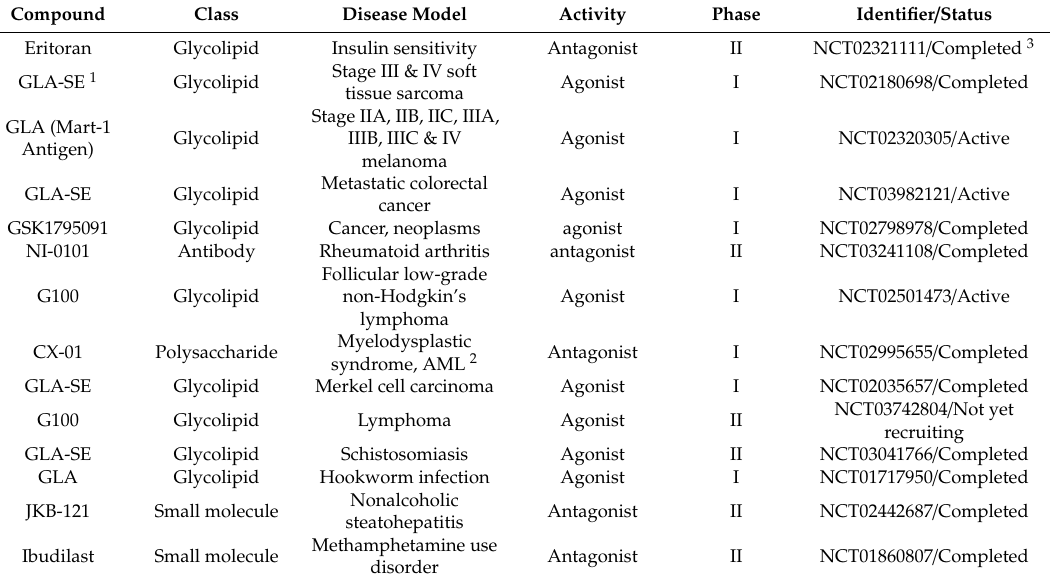
Table 2. TLR4-targeting ligands currently in clinical